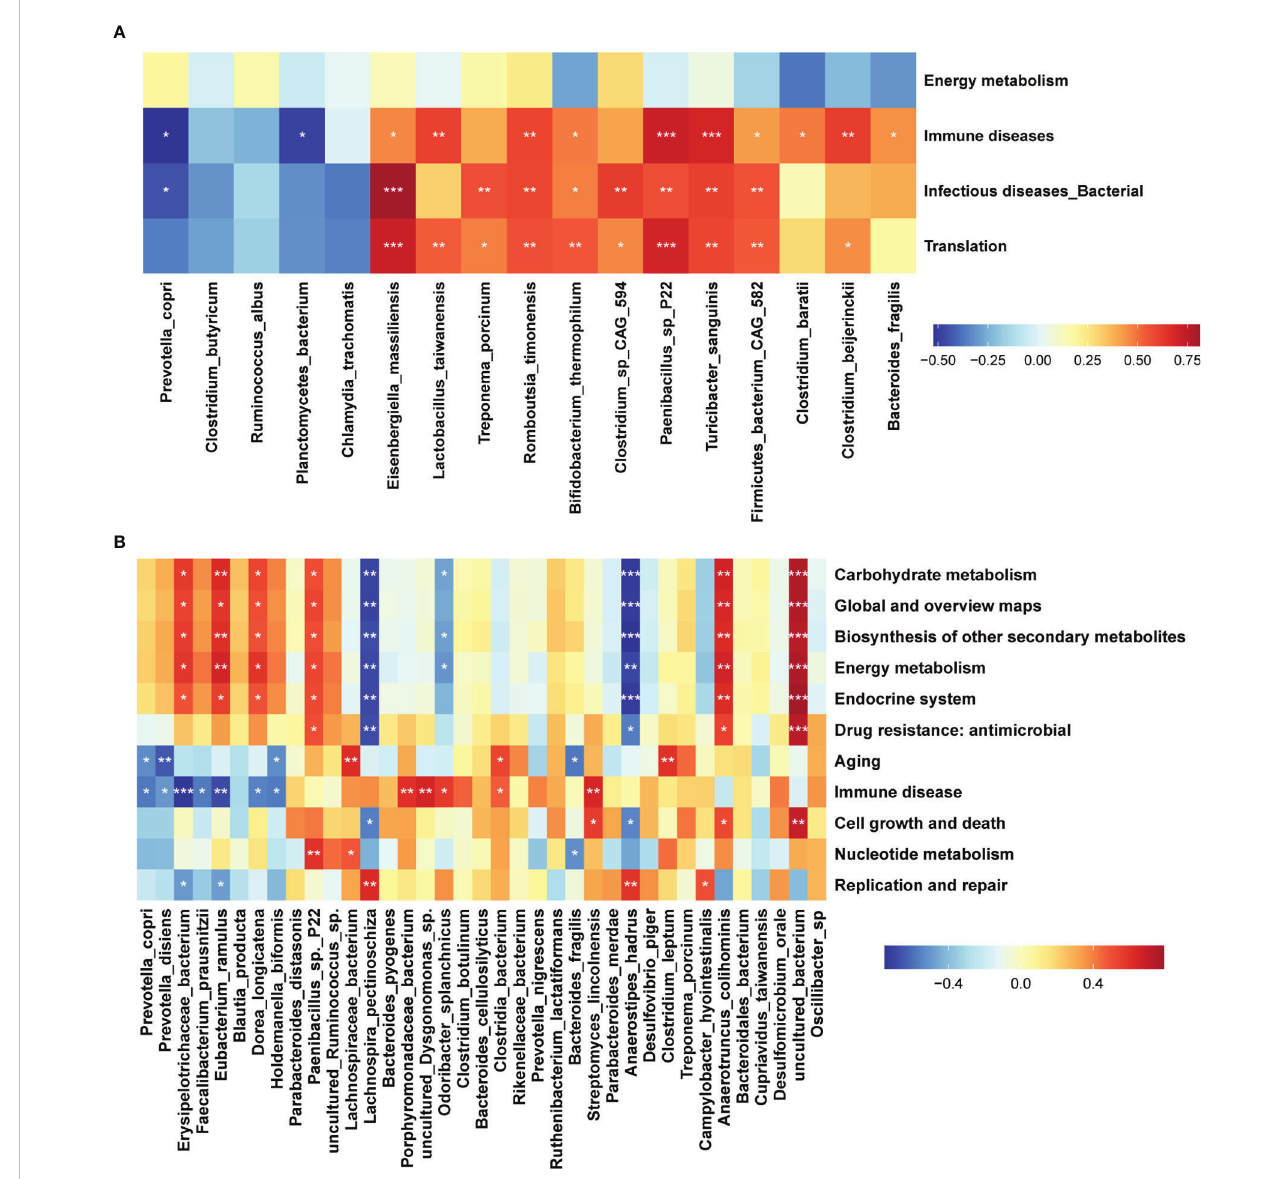
FIGURE 5 Correlations between differential function pathways and differential bacterial species. Heatmap showing the correlations between differential KEGG pathways of gut microbiome and differential bacterial species. The stars indicate the signi fi cance threshold of * P < 0.05 , ** P < 0.01 , and *** P < 0.001